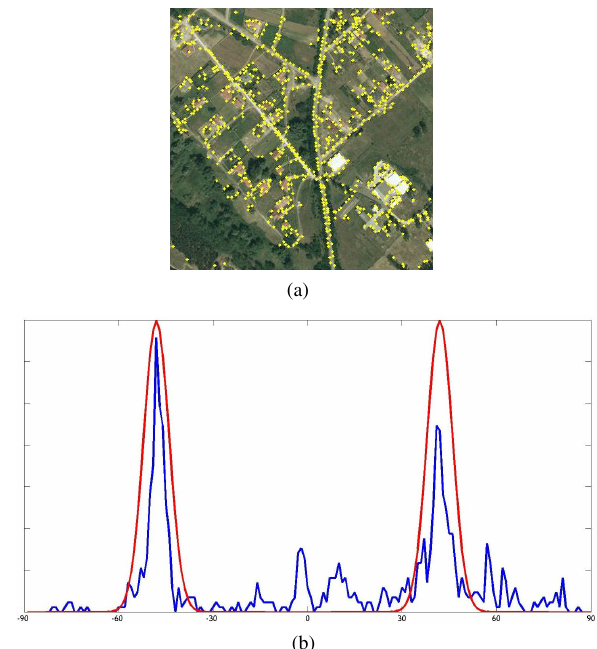
Figure 4: Orientation estimation for an image: (a) shows the feature points in yellow; (b) shows the λ i ( ϕ ) orientation density function of the points in blue, calculated for 15 × 15 neighbor- hood. ϕ ∈ [ − 90 , +90] is the horizontal axis, the number of points is the vertical axis. The η 2 ( . ) two-component Gaussian mixture is in red, detected peaks are θ = − 47 and θ ortho = +53 . (cid:107)∇ g r (cid:107) and k ( . ) kernel function with h with N i = (cid:80) r ∈ W n ( i ) bandwidth